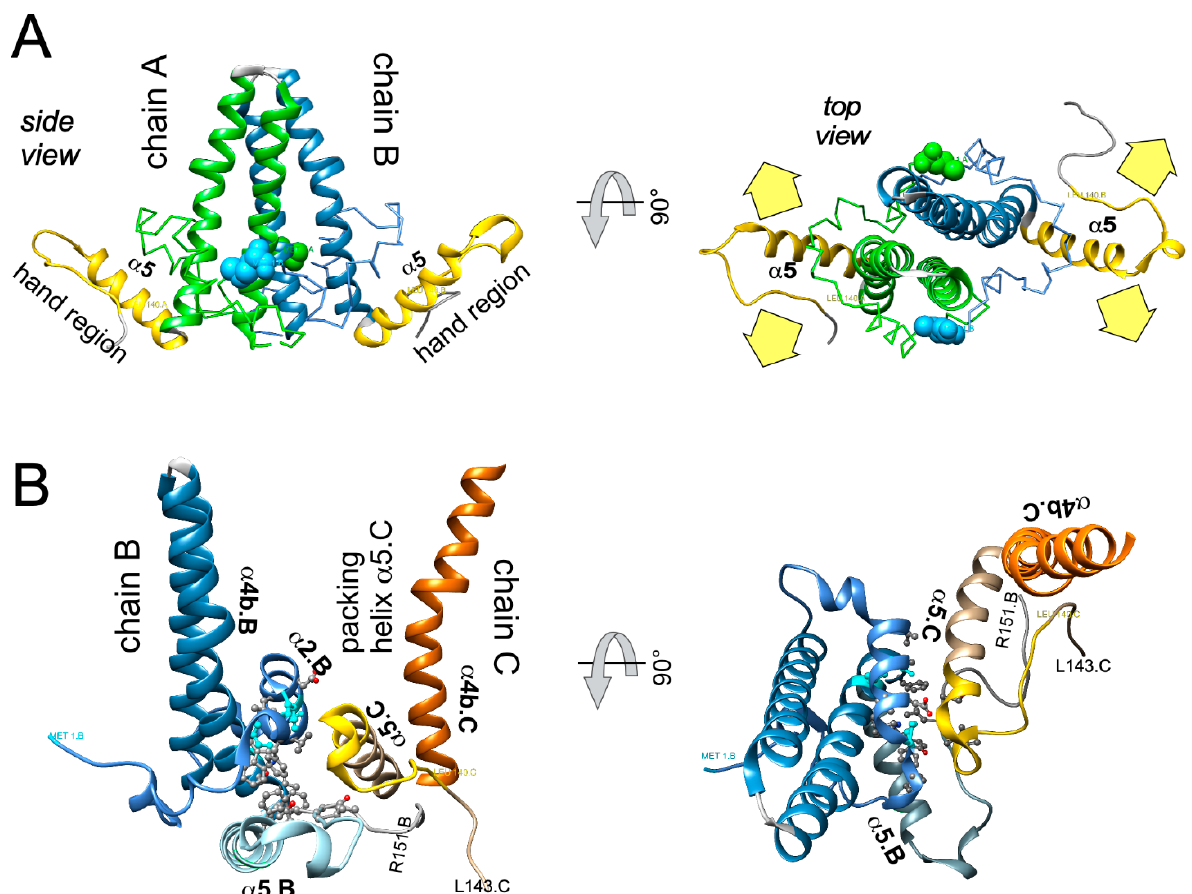
Figure 7. The HBV Cp inter-dimer interaction. ( A ) The Cp dimer is tetravalent. The “hand region” comprising helix α 5, the P-rich turn and the downstream sequence to the end of the assembly domain at L140 (highlighted in gold for each monomer) is the main module for inter-dimer contacts. Each hand region provides two interfaces, hence the dimer is tetravalent, as indicated by the broad yellow arrows in the top view. Only helices α 3, α 4, and α 5 are shown as ribbons. ( B ) Close-up of the B–C interdimer contact. For chain B the entire NTD is represented, for chain C only the descending helix α 4 and the hand region. Properly oriented chain B residues from F23 through helix α 2 (P25 to Y38), from α 4b (W102 to F110), plus W125 and residues from P138 to S141 form a largely hydrophobic cavity, against which α 5 from chain C can snuggly pack, in particular via V120, V124, W125, R127, T128, Y132, R133, P134, and P138. In the capsid, the respective residues undergo analogous interaction with their other neighbors. The pocket formed by the dimer–dimer interaction is the target for all currently known CAMs (“HAP pocket”) and the main site for CAM resistance confering mutations.